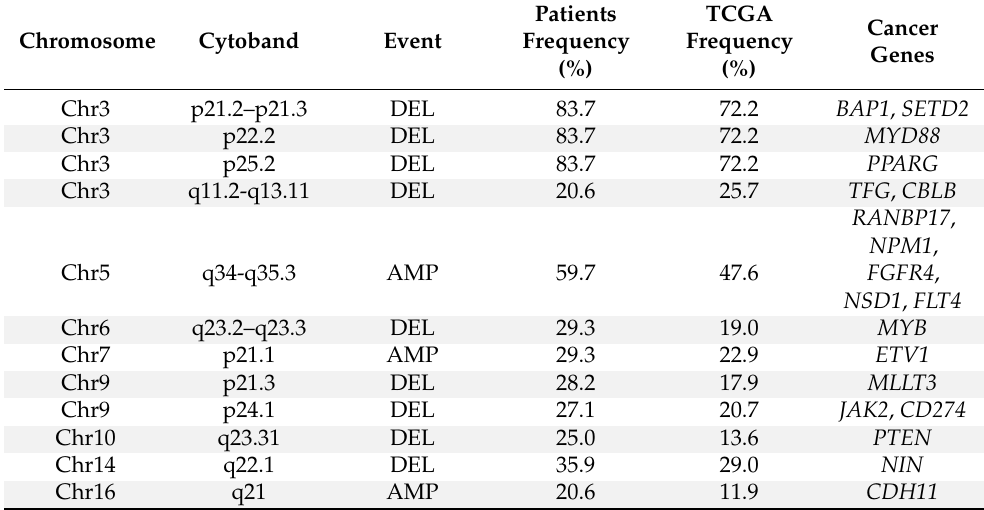
Figure 1. Somatic DNA copy number aberrations (CNAs) of 92 patients of ccRCC. In ( A ) The linear distribution of DNA gains (red) and losses (blue) and in ( B ) Chromosomal representation of all the aberrations. Table 2. Frequency of significant regions according to STAC with frequency ≥ 20% in the present casuistic and in